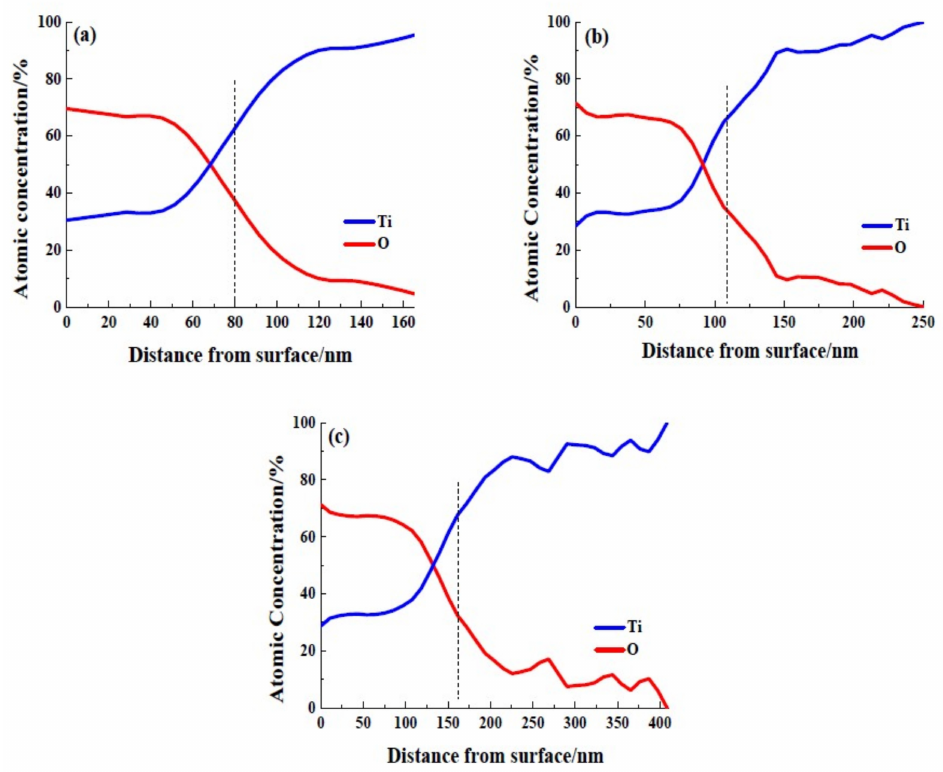
Figure 6. XPS depth profile of passive film and oxide film thickness vs. the anodic potential ( a ) Ti 10 ; ( b ) Ti 30 ; ( c ) Ti 50